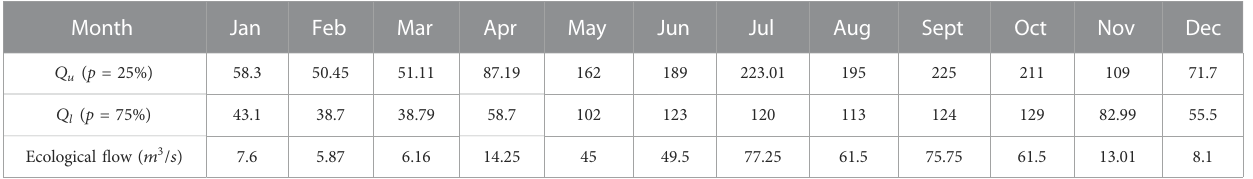
TABLE 4 Ecological Flow values calculated by the improved RVA method for each month at Wudu station.